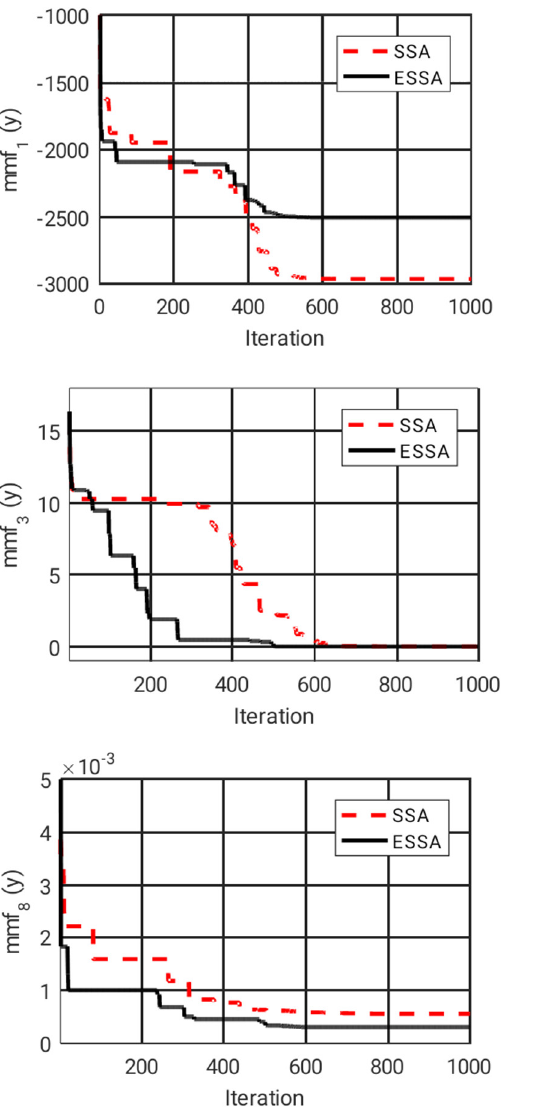
Figure 1. Convergence curves with SSA and ESSA for some mmfs . Table 2. Multimodal functions.